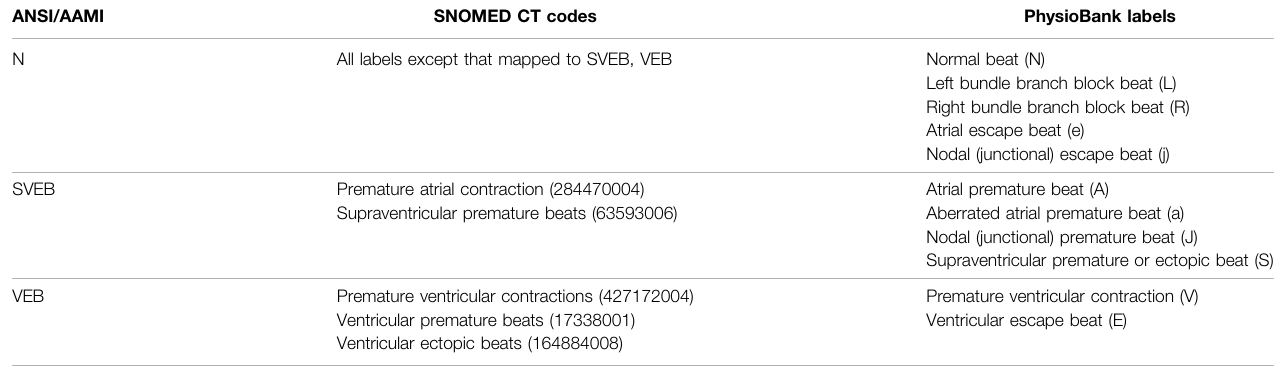
TABLE 1 | The mapping between the dataset labels and the classes suggested by the ANSI/AAMI standard. The dataset labels are in the parentheses following their corresponding class names. ANSI/AAMI